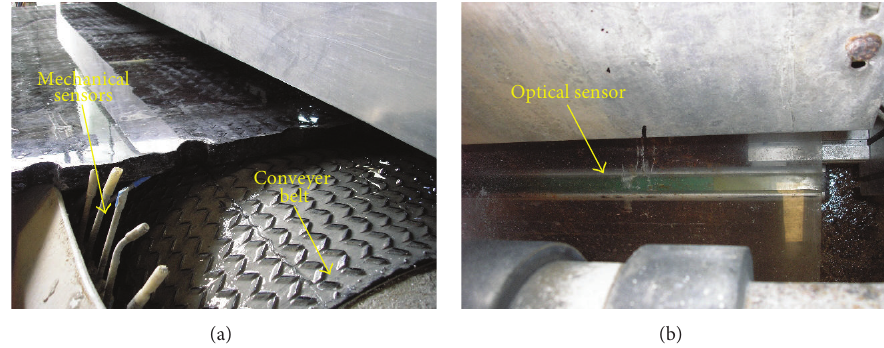
F 3: Mechanical sensors and optical sensors at the machine entrance